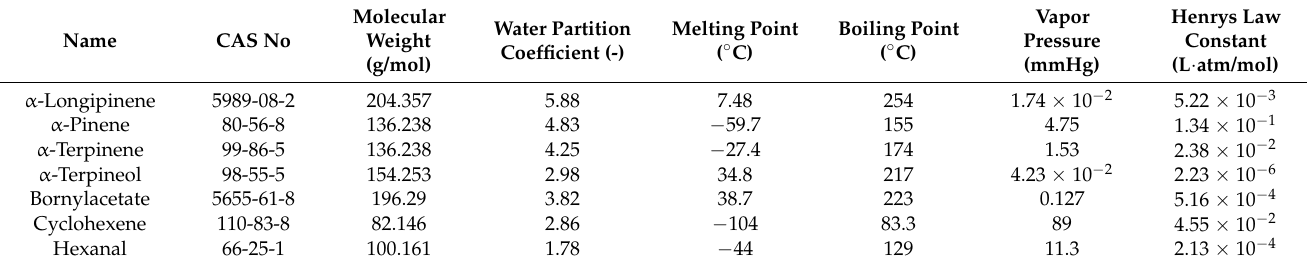
Table A2. Chemical properties of identified chemicals in wood and concrete. The table includes